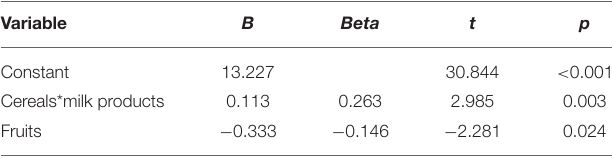
TABLE 7 | Regression analysis of diet consumption on the abnormal feelings of